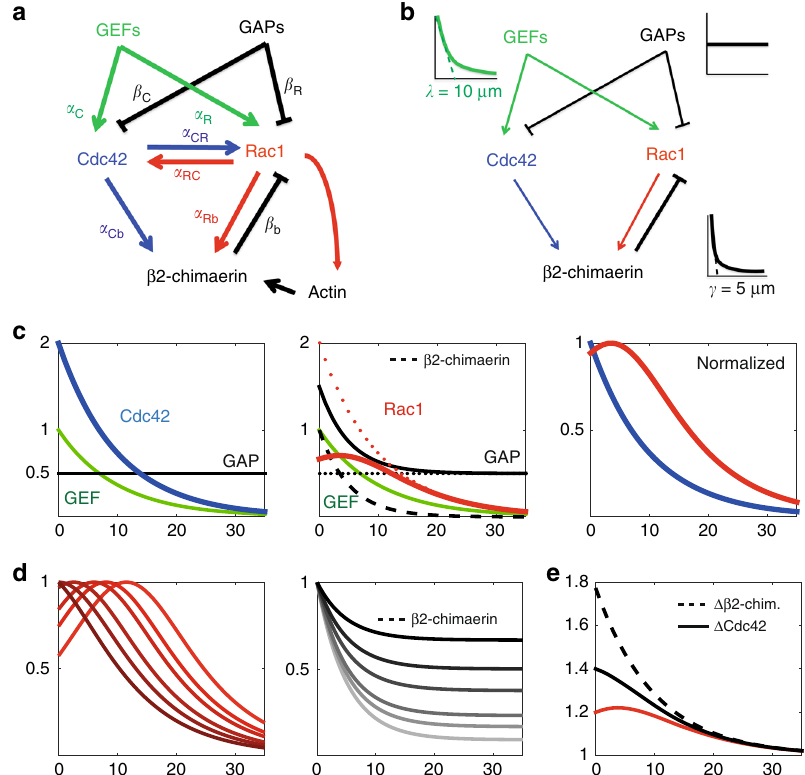
Fig. 4 A minimal model for Cdc42 and Rac1 gradient formation. a Full model based on our experimental fi ndings. Activation rates are denoted by α and deactivation rates by β . b A minimal model that recapitulates the formation of Cdc42 and Rac1 gradients. c Gradient shaping of Cdc42 and Rac1. Since the absolute amplitude of Rho GTPases are unknown, we assigned the following arbitrary values to the rates: α C = α R = 1; β C = β R = 0.5; and β b = 1. Left: Cdc42 (blue) is set by an exponentially distributed GEF (green) with a characteristic length λ = 10 µ m and uniform GAP (black). Middle: Rac1 (red) requires an additional GAP, β 2-chimaerin (dashed black, characteristic length γ = 5 µ m), that is localized more sharply at the cell edge than Rac1 GEF (green). The overall GAP activity (plain black) is the sum of β 2-chimaerin and a uniform GAP (dashed black). As a result, the putative Rac1 gradient without β 2- chimaerin (dashed red) is chopped off at the cell edge resulting in a bell-shaped gradient (plain red). Right: once normalized to 1, Cdc42 and Rac1 gradients present distributions that are similar to the ones measured in cells. d Effect of the relative ratio r = β R / β b between uniformly distributed GAPs and the localized gradient of β 2-chimaerin on the position of the Rac1 bump. Left: Rac1 gradients obtained with decreasing values of r ( r = 2, 1, 0.6, 0.3, 0.2, 0.1 respectively from dark to light red). Right: exponentially distributed β 2-chimaerin (dashed line) and uniformly distributed GAPs ( β R = 2, 1, 0.6, 0.3, 0.2, 0.1 from dark to light gray, solid lines) corresponding to the values used for the left plot. e Effects of Cdc42 or β 2-chimaerin inhibition in silico on the Rac1 ¼ 0 : 4, and α ¼ 0 : 3). The pro fi les are normalized (by the same factor) to match the FRET signal values measured experimentally (Fig. 2c, gradient ( α C b R b